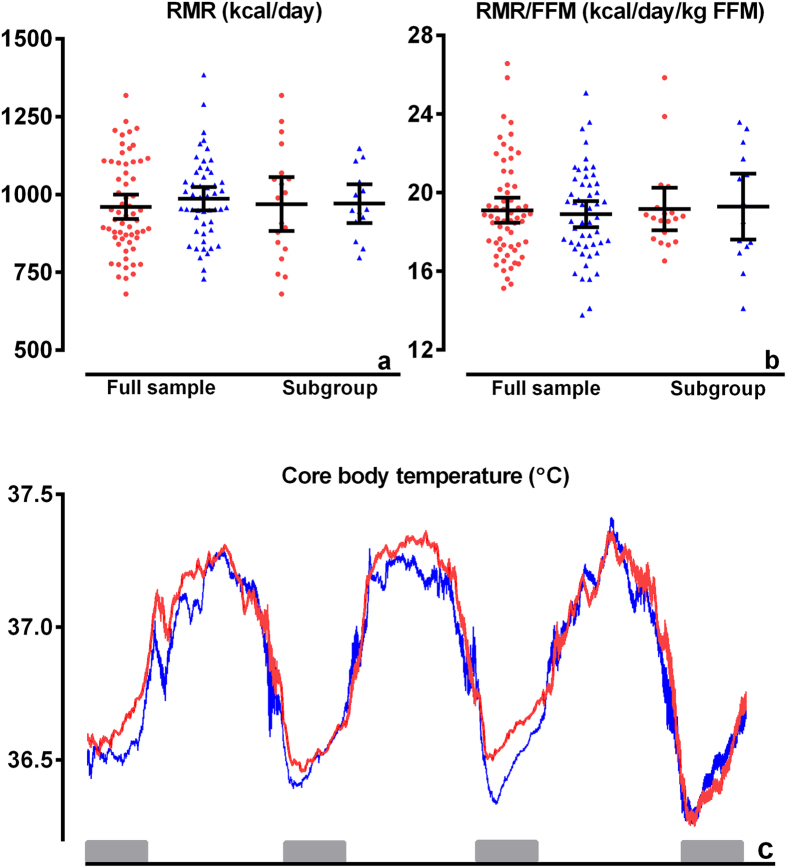
Parameters of energy metabolism in offspring from long-lived siblings and partners.Red circles represent offspring (n = 61 for full study sample; n = 20 for subgroup) and blue triangles represent partners (n = 51 for full study sample; n = 18 for subgroup). (a) Mean (95% CI) resting metabolic rate (kcal/day). (b) Mean (95% CI) resting metabolic rate per kg fat free mass (c) Mean (SEM) core body temperature per 5 minutes over 3 days in full study sample offspring (red line) and partners (blue line). Grey blocks are the night periods (24.00h–07.00 h). RMR: resting metabolic rate; FFM: fat free mass. *P ≤ 0.05; **P ≤ 0.01; ns: not significant.